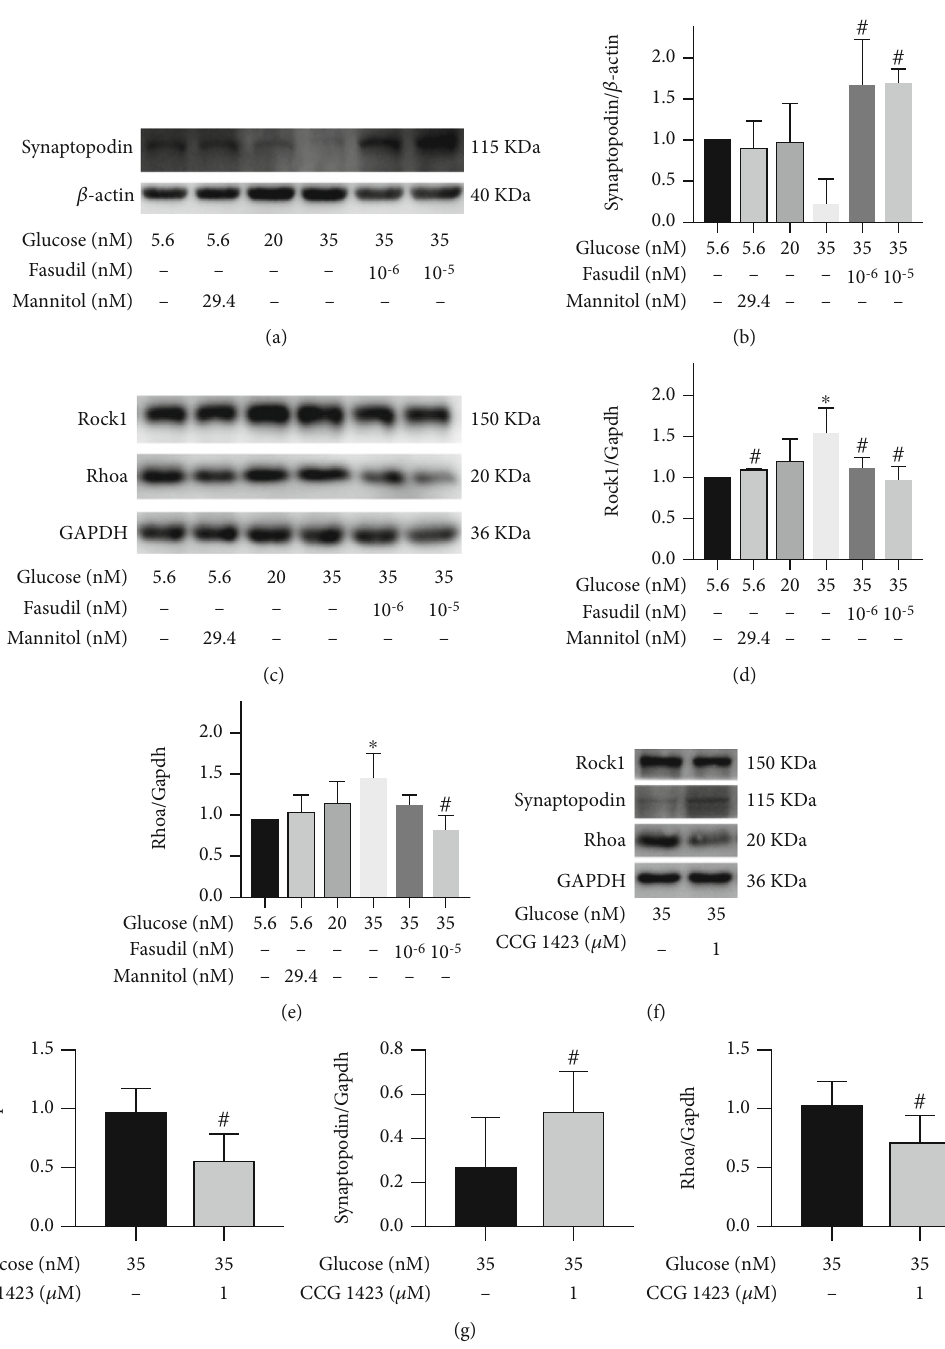
Figure 5: E ff ects of HG and fasudil on synaptopodin and RhoA/ROCK1 proteins in podocytes in vitro. (a, b) The dose-dependent e ff ects of HG and fasudil on synaptopodin protein and their semiquantitative analysis. (c – e) The dose-dependent e ff ects of HG and fasudil on RhoA/ROCK1 proteins and their semiquantitative analysis. (f, g) The e ff ects of CCG-1423 on synaptopodin and RhoA/ROCK1 proteins in HG (35.0 mmol/L glucose) and heir semiquantitative analysis. ∗ P < 0 : 05 versus the control group (5.5 mM glucose), # P < 0 : 05 versus the HG (35 mM)